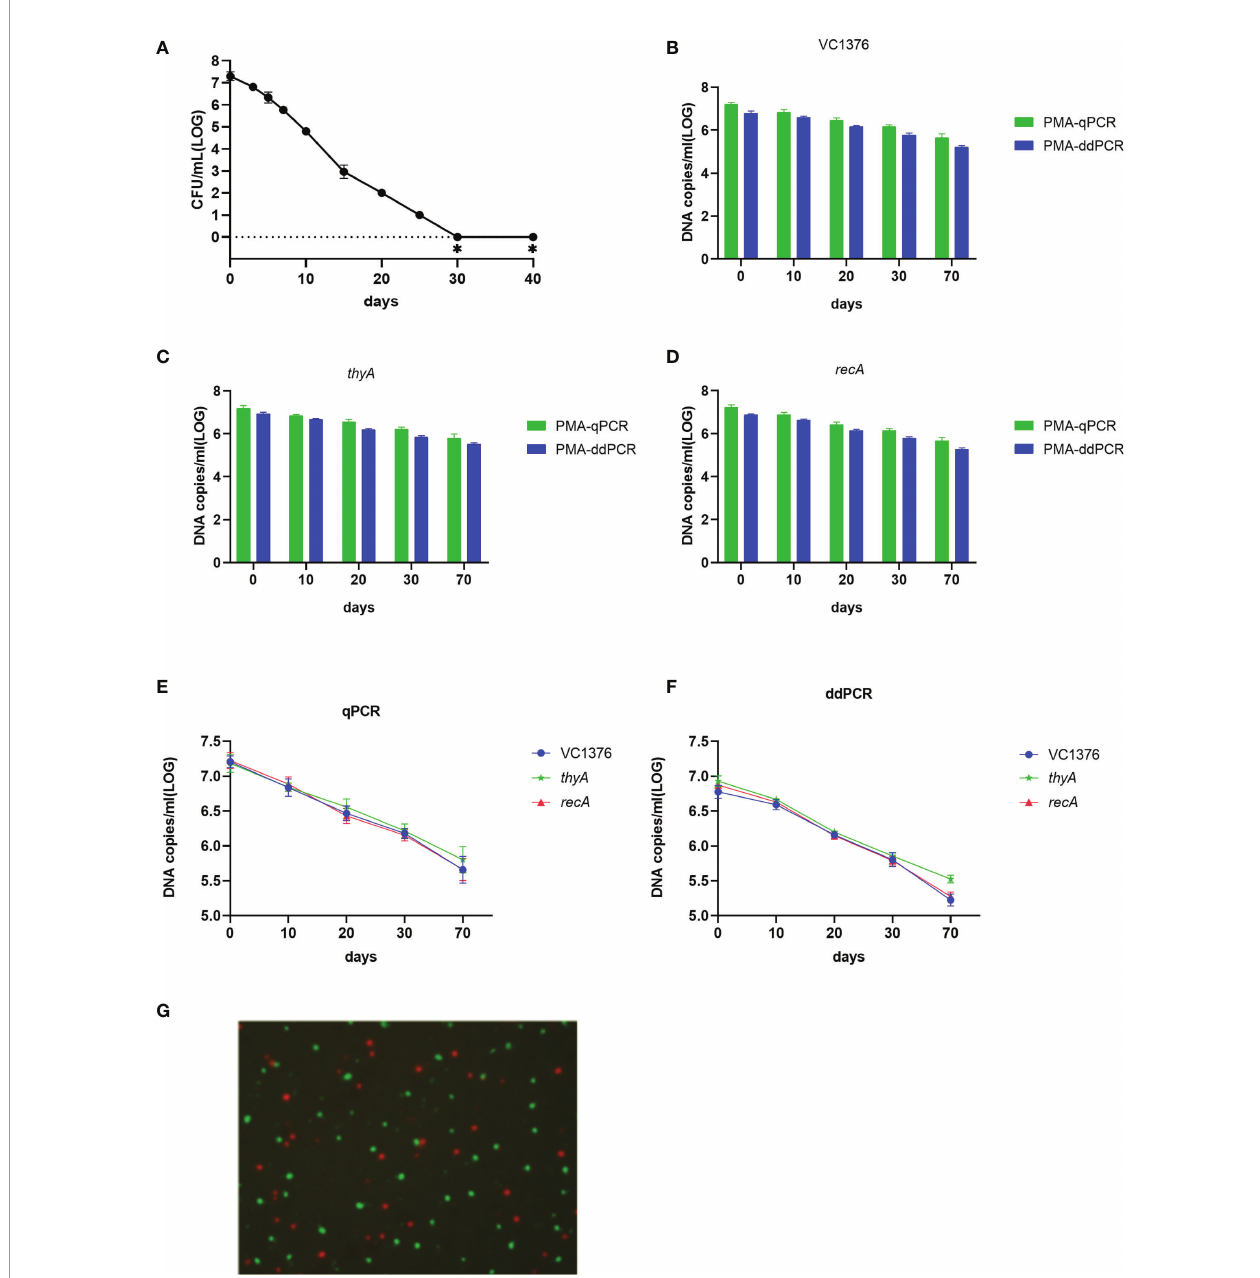
FIGURE 2 | Enumeration of viable cells by qPCR and ddPCR during VBNC-state development of V. cholerae strain C6706. (A) Culturable cell counts during VBNC- state development of strain C6706. ∗ indicates that the culturable cell count was <1 colony-forming unit/mL. (B – D) DNA copies/mL measured using genes VC1376, thyA and recA after PMA treatment. (E, F) Change in number of DNA copies/mL measured by qPCR or ddPCR for determination of viable cell counts during VBNC- state development. (G) Live/Dead staining of cells of V. cholerae strain C6706 on day 70 of VBNC-state development. Viable cells, which are stained only by SYTO9, appear green; dead bacteria appear